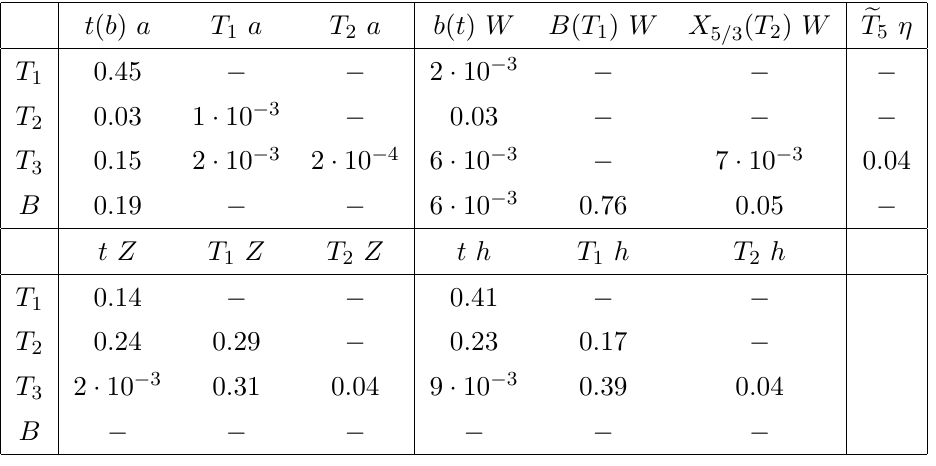
Table 1 . Branching ratios of the VLQs in the benchmark scenario Bm1 for a (cid:12)xed value of the a mass, m a = 15 GeV, while m (cid:17) = 100 GeV. The absence of number for a given BR indicates that the decay channel is not kinematically allowed or the corresponding tree-level coupling vanishes. The parenthesis in the (cid:12)rst row refer to the decay channels of the VLQ B while the others channels corresponds to the VLQs T 1 ; 2 ; 3